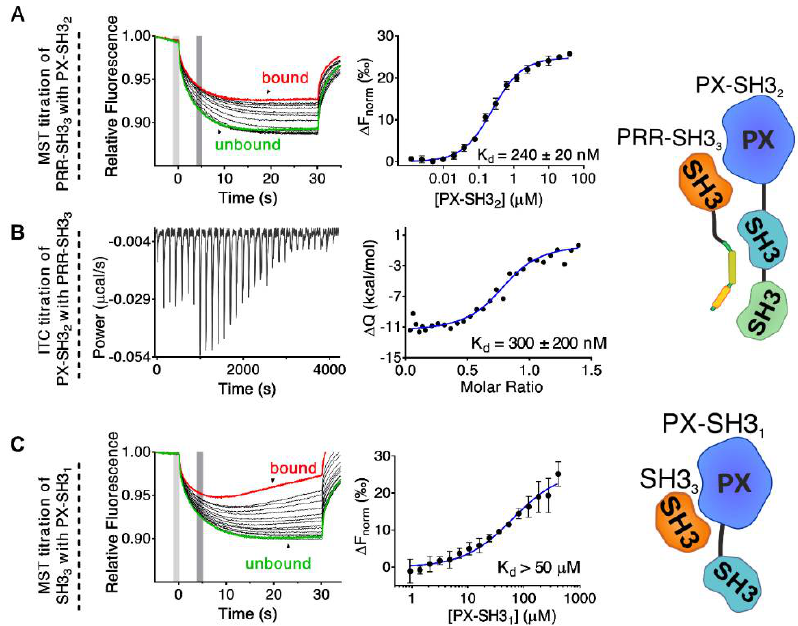
Figure 2. Determination of the intramolecular interactions in the Tks4 N -terminus via MST and ITC. Titration of PX–SH3 2 with PRR–SH3 3 was followed by MST ( A ) and ITC ( B ). Similar dissociation constants were observed via both methods (MST: K d = 240 ± 20 nM, ITC: K d = 300 ± 200 nM). The titration of PX–SH3 1 with SH3 3 was followed by MST ( C ). Due to the relatively weak interaction, only a lower limit was determined for the dissociation constant (K d > 50 µ M). Left panels: MST and ITC traces, right panels: dose-response curves. The change in the normalized fluorescence ( ∆ F norm ) in the MST experiments was calculated as the ratio of the average fluorescence in the “cold” (light gray area) and “hot” states (dark gray area) of the system. MST traces corresponding to bound and unbound states of the fluorescently labeled proteins are highlighted in red and green, respectively. Dose-response data were analyzed by fitting to a quadratic equation describing a simple molecular interaction with a 1:1 stoichiometry (MST) or using the “one-set-of-independent-sites” model (ITC). Error bars depict the standard deviation of three independent measurements.